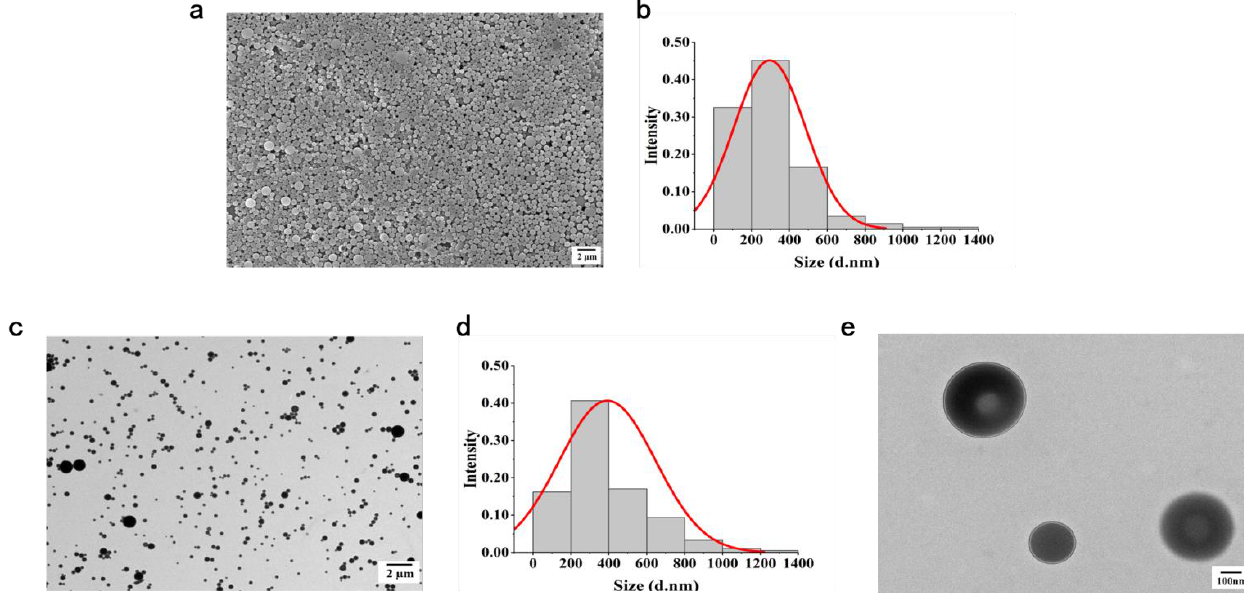
Figure 1. Hydrodynamic particle sizes and polydispersity indices (PDIs) determined by dynamic laser scattering after different emulsification powers had been used.